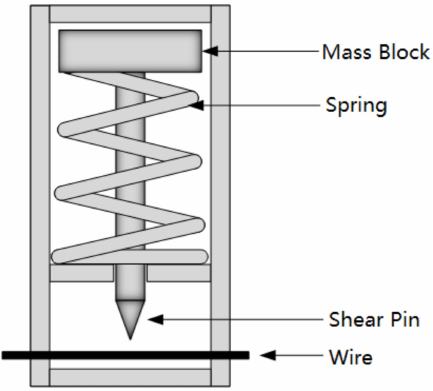
Figure 2. Schematic diagram of the